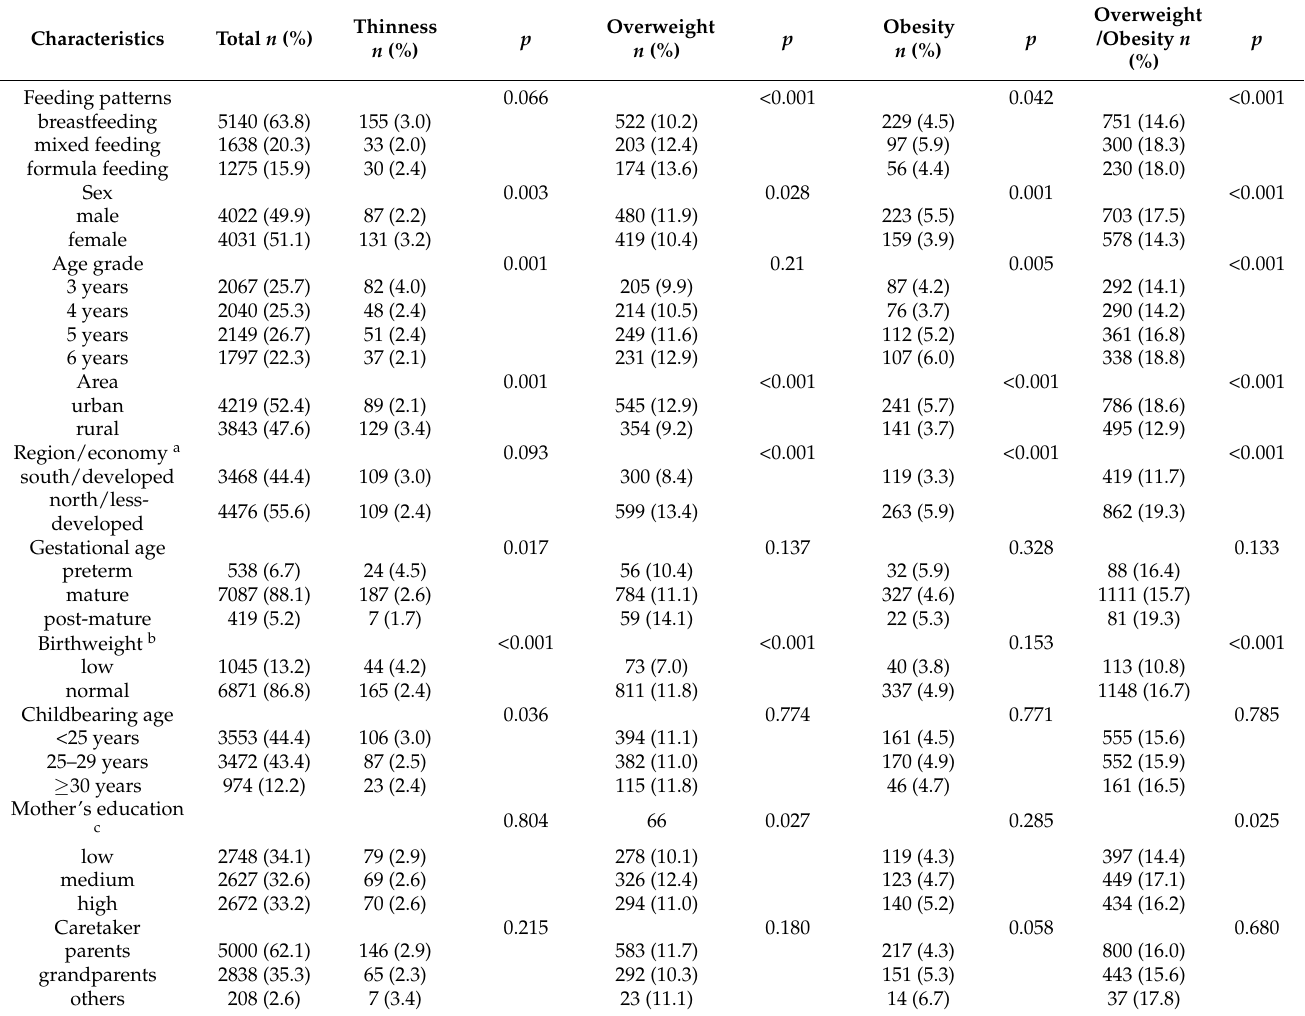
Table 1. Participants’ characteristics and univariate analysis of thinness, overweight, and